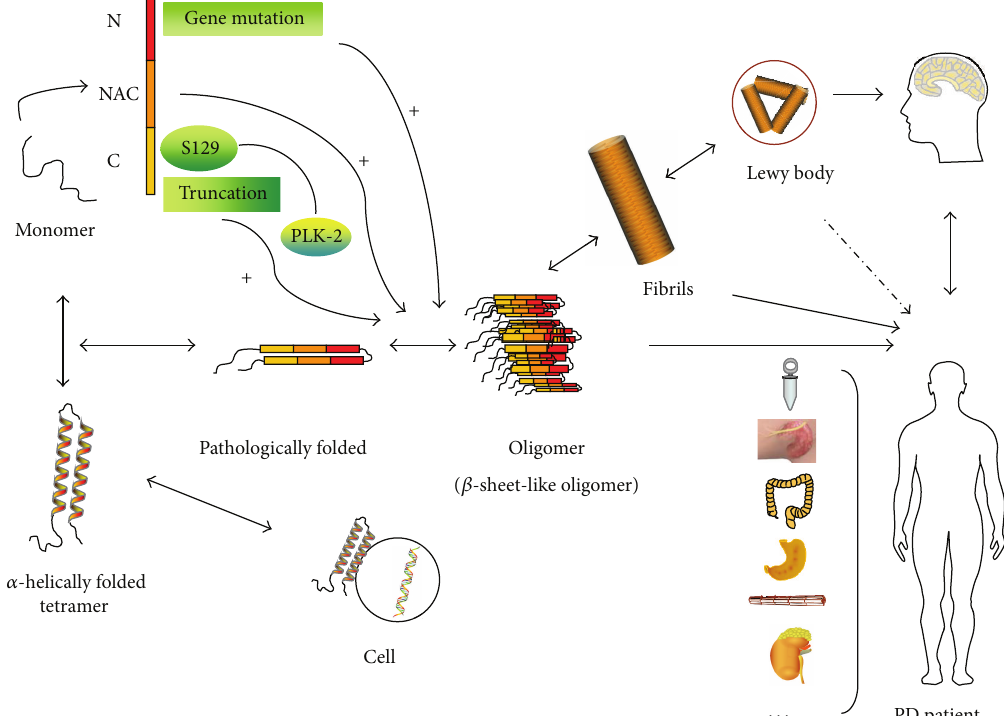
Figure 1: Alpha-synuclein’s aggregation pathway and role as a diagnostic biomarker in PD. Alpha-synuclein is a small protein comprising 140 amino acids with three domains that exist in dynamic states. The 𝛼 -helically folded tetramer is thought to be only adopted upon membrane binding. The three domains each have a role in aggregation, as shown in the figure. All known gene mutations are found in the N-terminal domain, and some have been proven to accelerate aggregation. The NAC domain has a stretch of 12 amino acid residues that are unique and typical in the formation of oligomers and fibrils. C-terminally truncated 𝛼 -synuclein appears to aggregate faster. In addition, the phosphorylation of amino acid 129, located in C-terminal domain, plays a central role in the pathway and is promoted by PLK2. Alpha- synuclein leads to toxicity when aggregated into pathological oligomers, fibrils, and Lewy bodies. In the search for a diagnostic biomarker in PD, 𝛼 -synuclein from the CSF, plasma, the submandibular gland, saliva, colonic and gastric mucosa samples, and peripheral nerve fibers has been